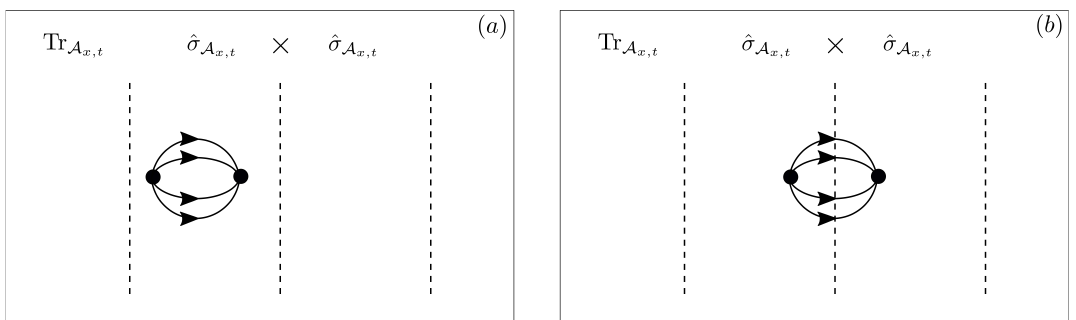
ˆ σ N up to O ( K 2 ) , A x , t A x , t . The symmetry in the x , t